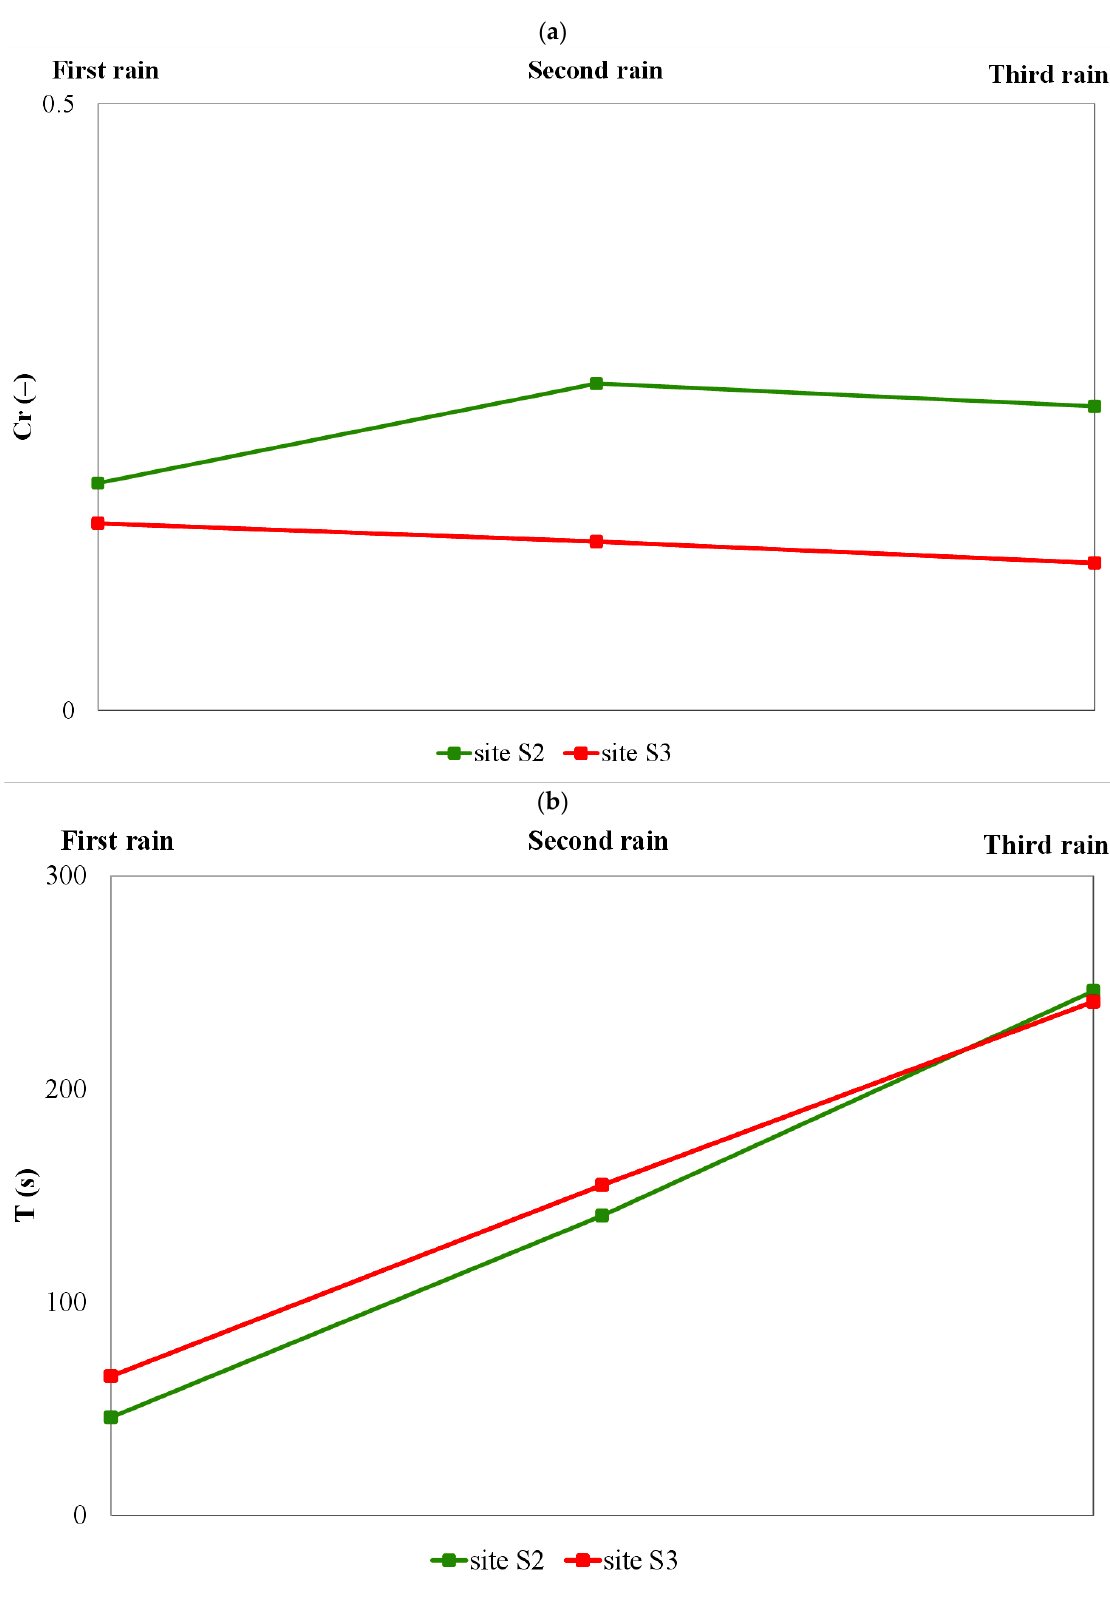
Figure 5. The surface runoff coefficient, C r ( a ) and time to runoff, T ( b ) in sandy soil in a sequence of three consecutive rain events conducted at sites S2 and S3 at Studienka village in the Borská nížina lowland (southwestern Slovakia).